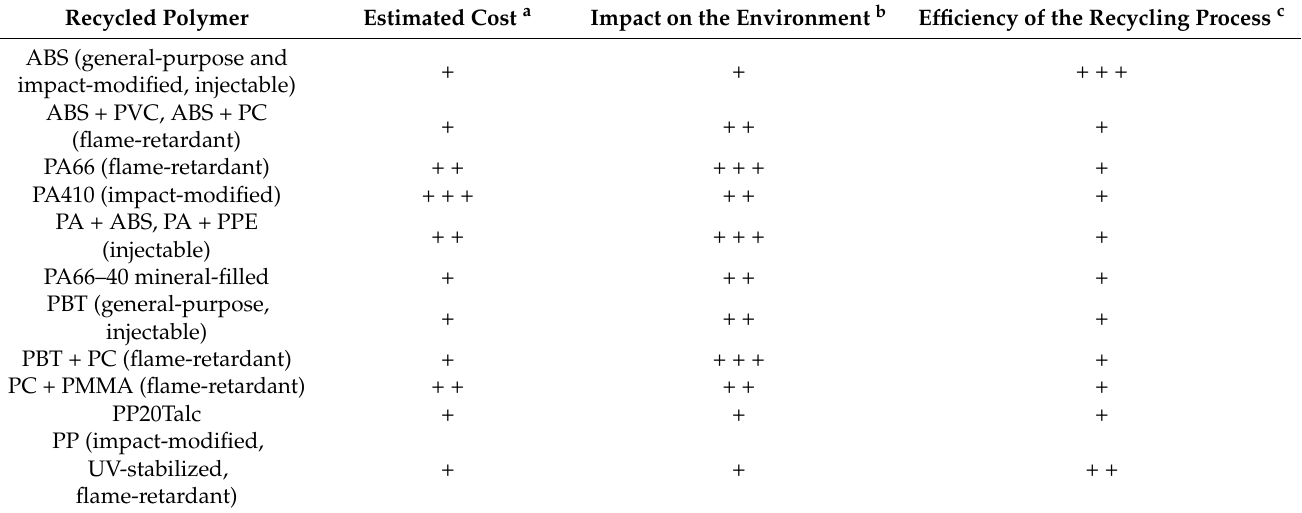
Table 3. Impact of recycling